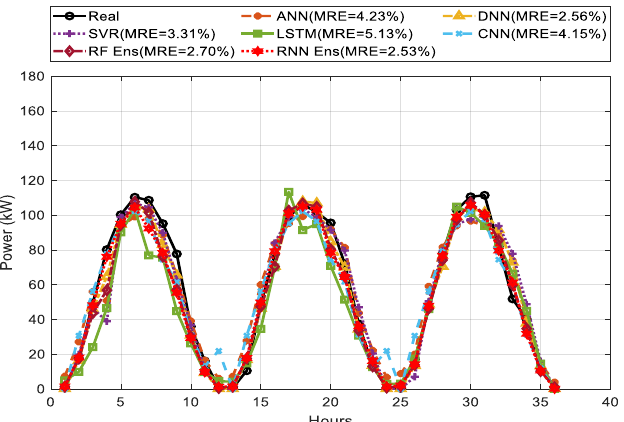
Figure 12. One-day ahead PV power forecasting results for rainy days between single model and Figure 13. Three-day ahead PV power forecasting results for sunny days between single model Figure 13. Three-day ahead PV power forecasting results for sunny days between single model Figure 13. Three-day ahead PV power forecasting results for sunny days between single model ensemble model. and ensemble model. and ensemble model. and ensemble model.